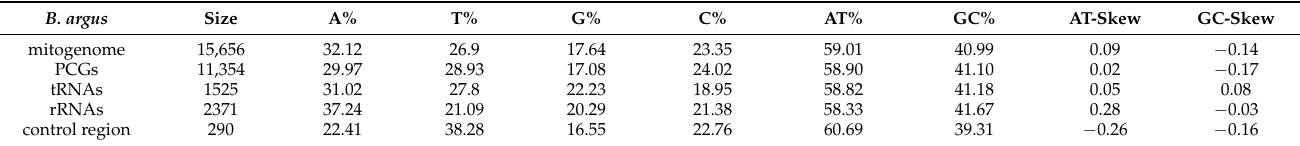
Figure 1. Mitochondrial genome map of B. argus . Genes encoded in the forward direction are located on the outside of the ring, while those encoded in the reverse direction are located on the inside of the ring. The black peak represents the deviation of GC%; the deep purple and green peaks represent the deviation of GC skew. Table 2. Nucleotide composition and AT-GC skewness of the B. argus